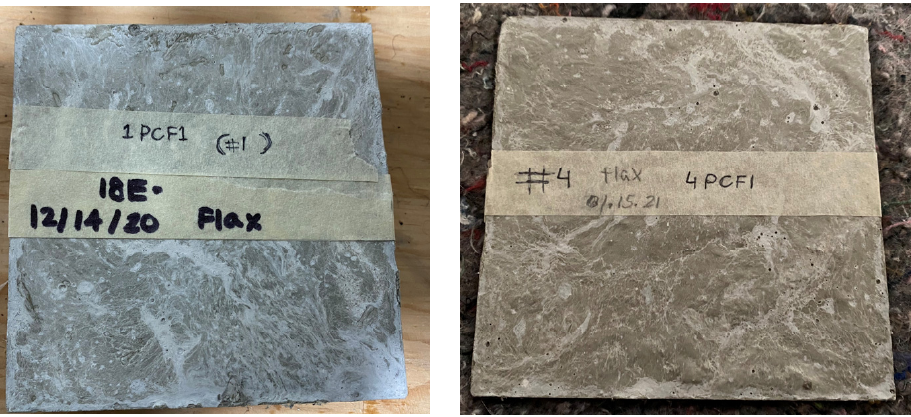
Figure 4. Kraft-paper honeycomb sandwich samples for thermal conductivity tests.